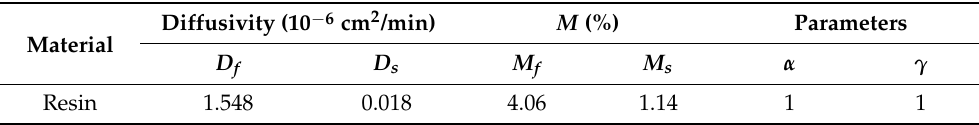
Table 2. Parameters in time-fractional diffusion equation for neat